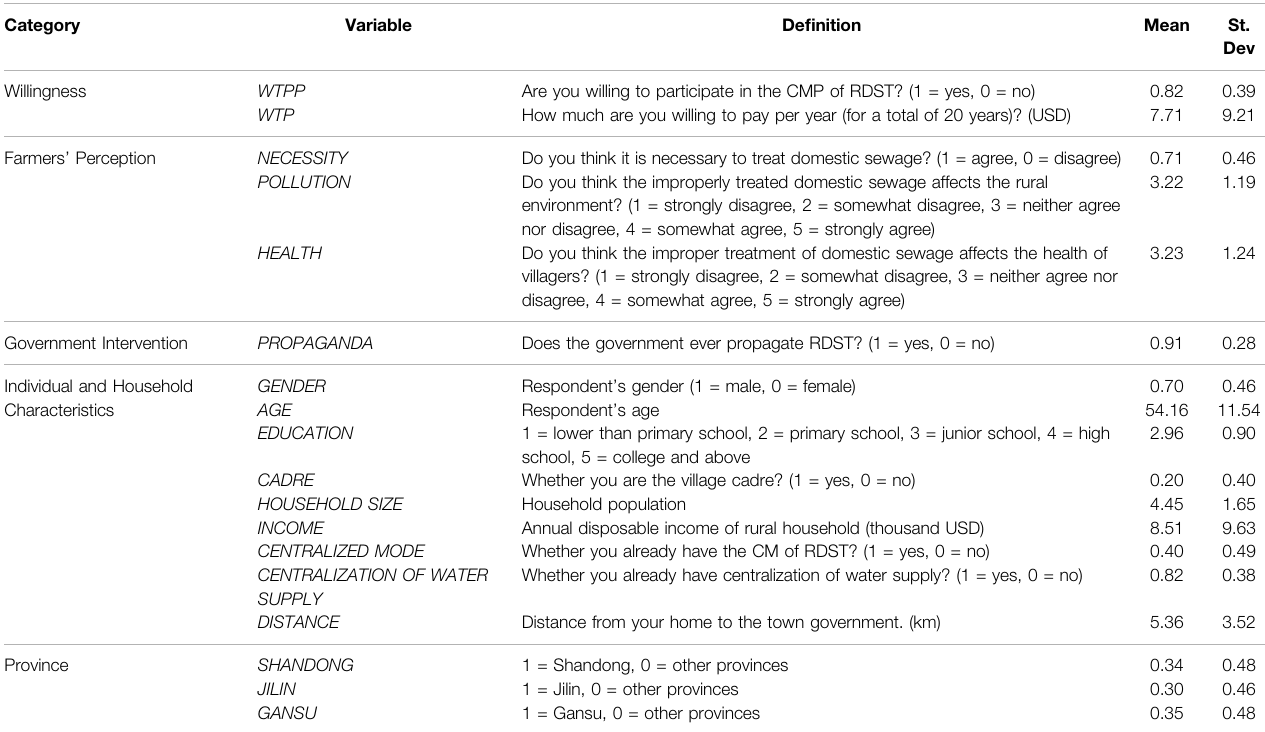
TABLE 1 | Variable de fi nitions and summary statistics.